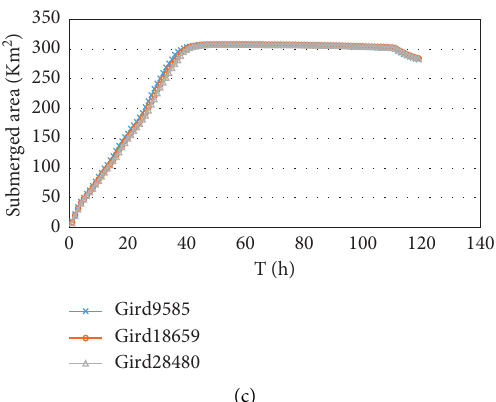
Figure 7: Comparison of the simulated variables at different grid resolutions. (a) The time series of water depth at different gauges. (b) Max water depth at different gauges. (c) The time series of submerged